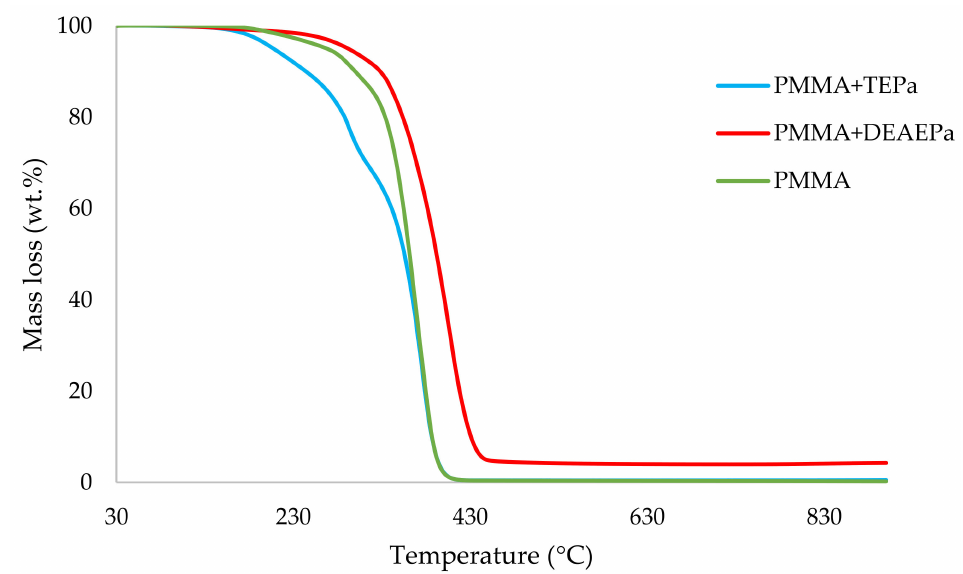
Figure 6. An overlay of the TGA curves of PMMA and PMMA + phosphate